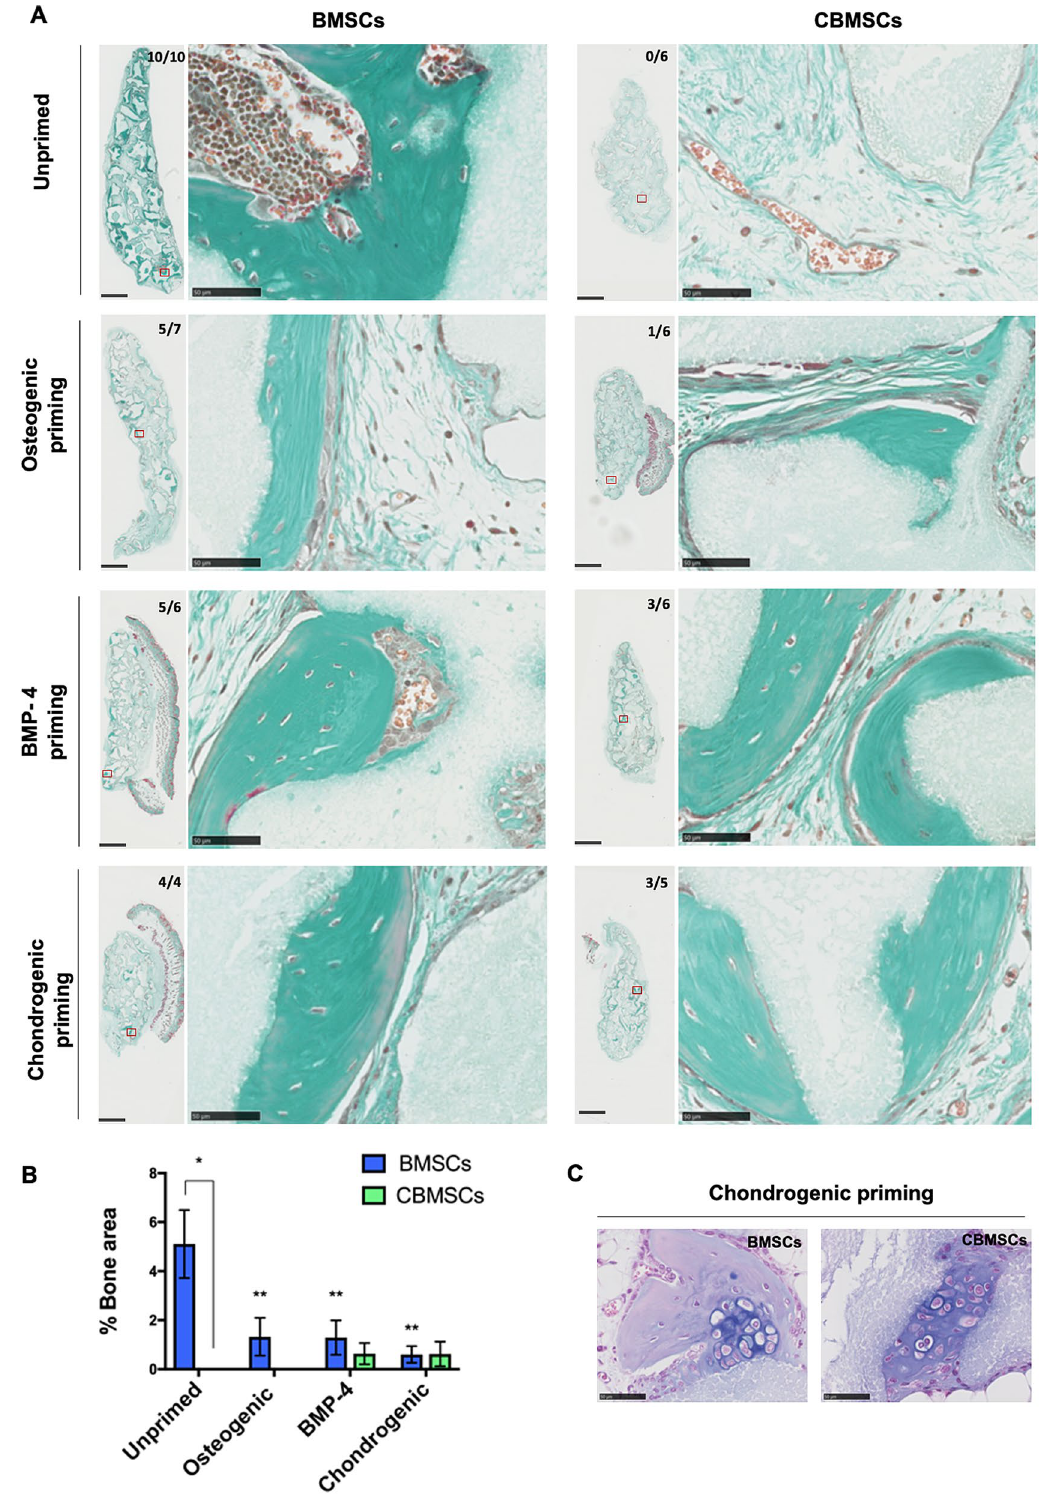
Figure 5. Ectopic bone formation by implantation of BCP biomaterial in combination with either BMSCs or CBMSCs, w/o priming prior to implantation in nude mice. ( A ) Masson’s trichrome staining of explanted tissue sections after 8 weeks. Newly formed bone is evidenced in green, while BCP biomaterial is shown in grey. The bone incidence score on each group represents the number of implants with newly formed ectopic bone over the total number of implants in that group. The red box on the whole implant sections represents each magnified image presented. Scale bars represent 1 mm and 50 μm for whole implants and magnified images respectively. ( B ) Histomorphometry quantification of ectopic bone formed in each group. Data are presented as mean ± SEM of the mean. ( C ) Alcian blue staining of explants after 8 weeks in subcutis sites. Cartilage was observed in both BMSC and CBMSC groups, but only when cells underwent chondrogenic priming prior to implantation. Statistical analysis was by two-way ANOVA followed